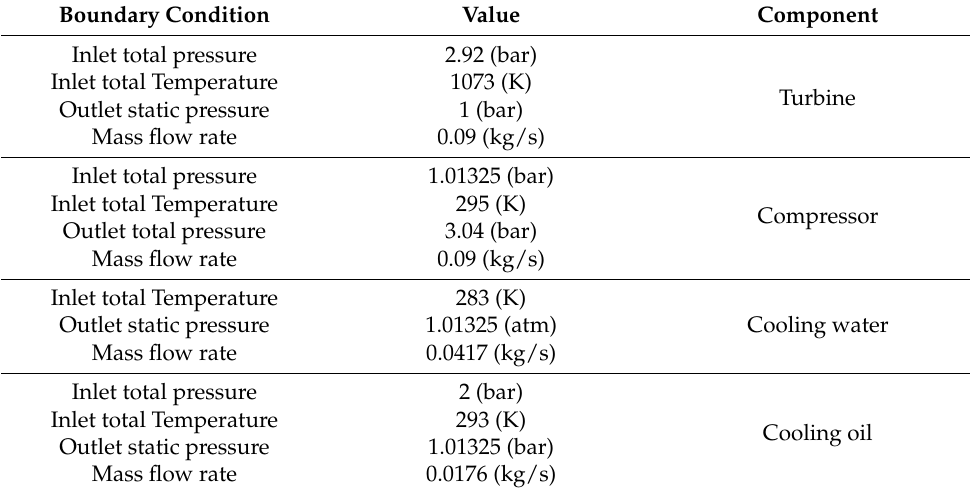
Table 3. MGT components’ boundary